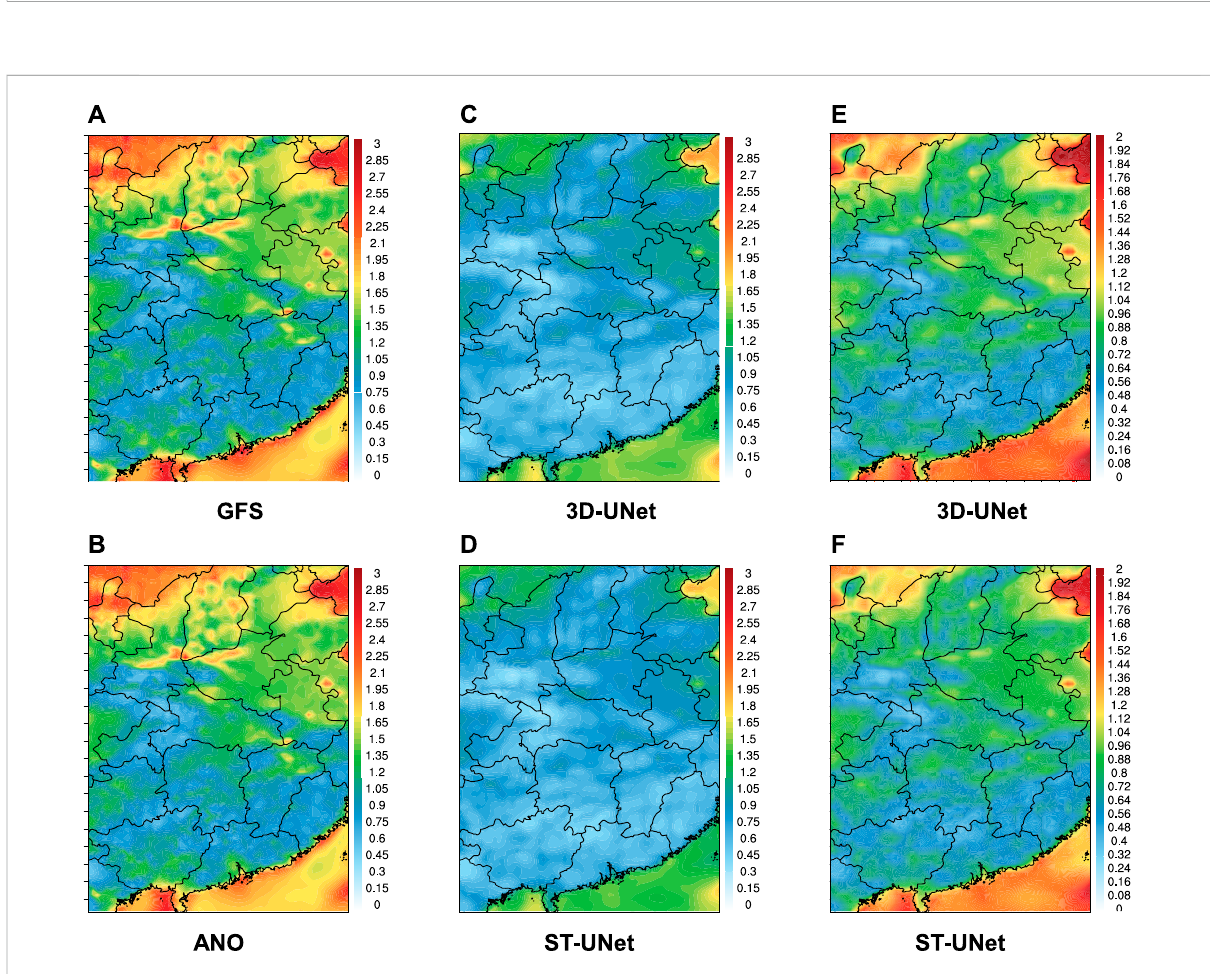
FIGURE 9 The RMSE spatial distribution of bias correction for the 10-m u component of wind on the test set over the study